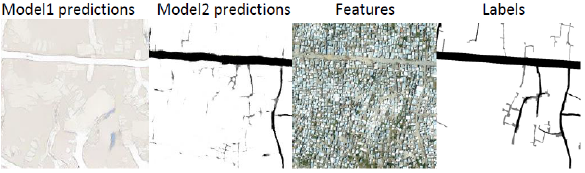
Figure 9. The GANs-UNet model for a very complex